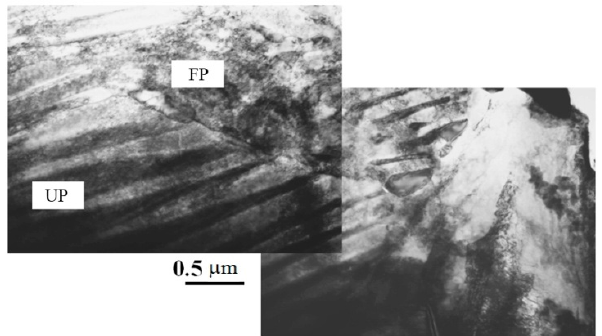
Figure 7. Image of the structure of lamellar pearlite in the zone of localized deformation of a destroyed specimen of 0.2 С steel (UP—unfragmented, FP—fragmented pearlite). Transmission electron microscopy.